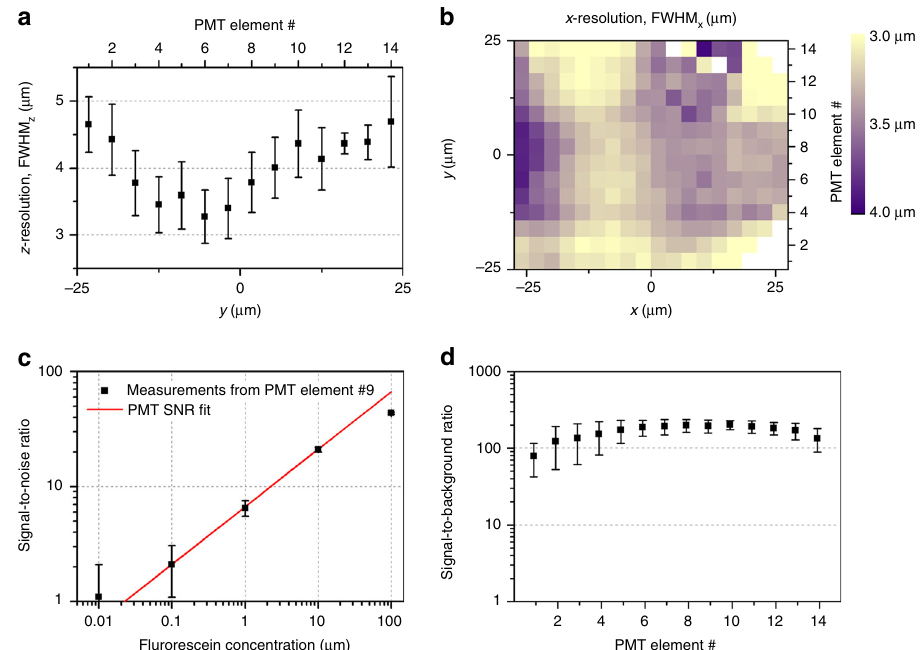
Fig. 2 Resolution and detection limit characterization of the LEAD microscope. Fluorescent beads imaged within the device resulted in PSFs ranging between ( a ) 3.4 – 4.7 μ m (FWHM) in the z -direction and ( b ) 3.0 – 4.1 μ m (FWHM) in the x -direction across the FOV. No beads were detected along some edges of the device in ( b ) due to the parabolic fl ow velocity pro fi le of beads in the device. c The detection limit is determined by measuring the signal-to- noise ratio (SNR) of different concentrations of fl uorescein fl owing in the device. An SNR model for PMTs gives a collection ef fi ciency of the system of 2.9 ± 1.2% and a detection limit (SNR = 1) of 22.3 ± 9.0 nM, corresponding to 420 ± 170 molecules of fl uorescein imaged by each PMT element. Uncertainty arises from the varying signal level across experimental repeats. d Signal-to-background ratios (SBR) of polyQ40 strain C. elegans moving at 1 m s − 1 imaged with our platform. SBR exceeds 200 for the center PMT elements and drops off for surrounding elements due to their decreased responsivity. Uncertainty arises from the varying fl uorescence for different samples. For all panels, data are mean and error bars are